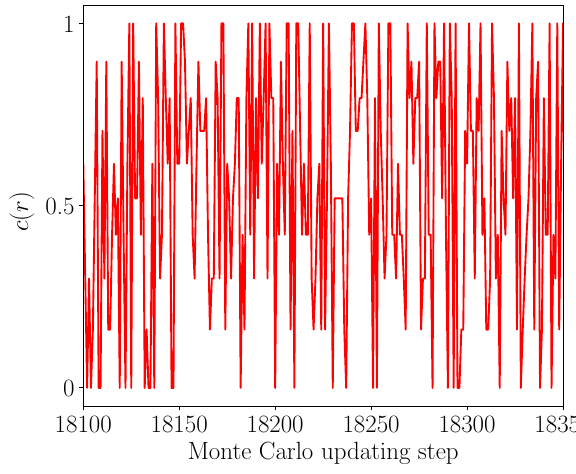
Figure 3 . Random walk of a configuration among different replicas during a parallel tempering run for N = 4, β = 11 . 347 and θ L = 0. Replicas are parametrized by their value of c ( r ) and the Monte Carlo time is expressed in units of the parallel tempering update step defined in the